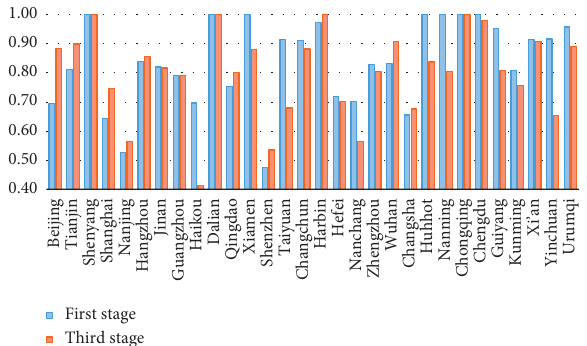
Figure 3: Comparison of average operation efficiency before and after adjustment (2010–2016).